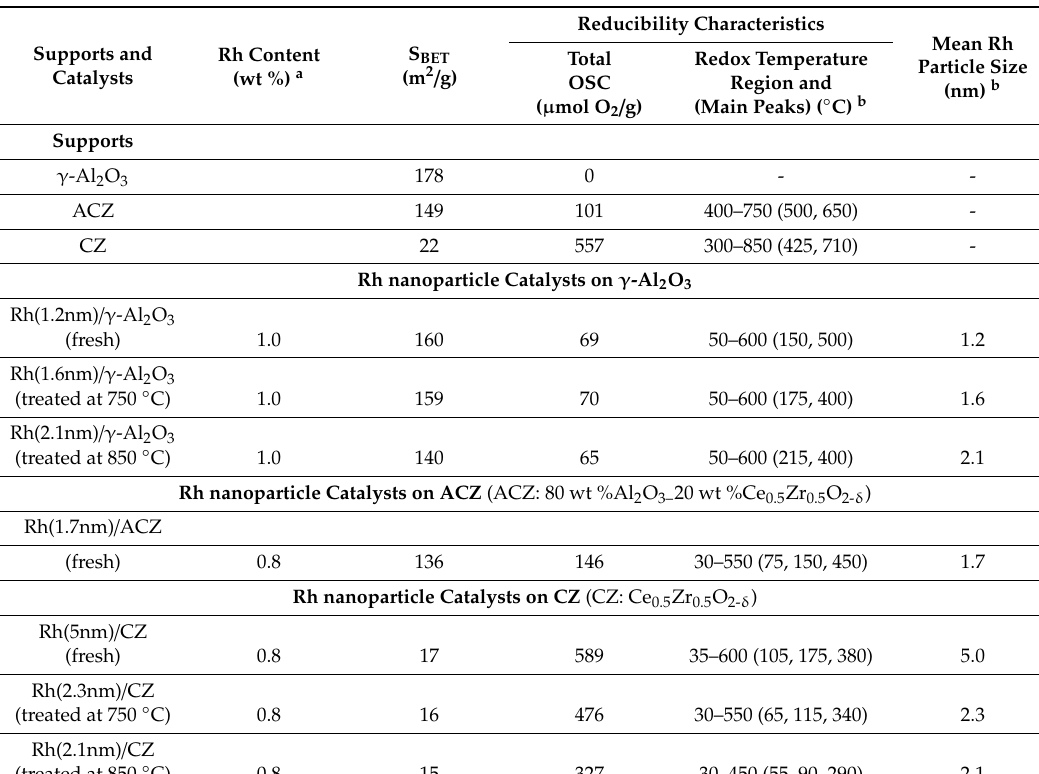
Table 1. Characteristics and properties of supports and the counterpart Rh catalysts (fresh or treated at high-temperature oxidative conditions: 750 or 850 ◦